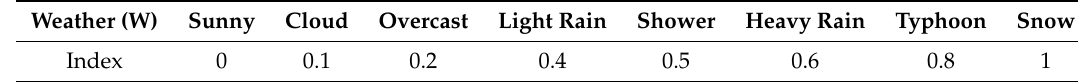
Table 2. Quantization for the factors of weather.